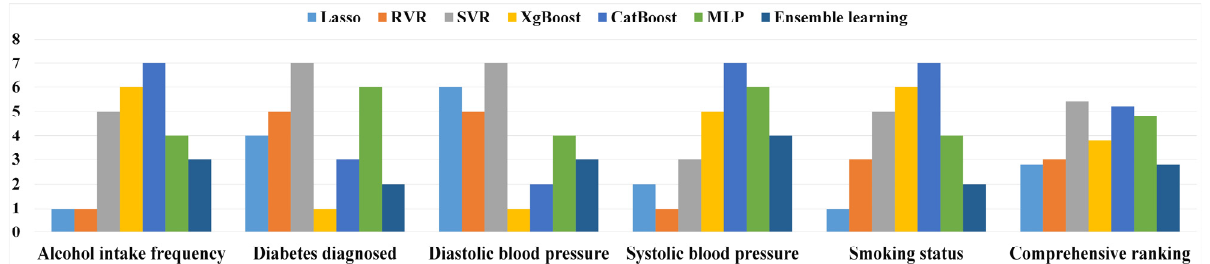
Figure 6. Ranking results of seven ML model on fi ve non-IDPs.